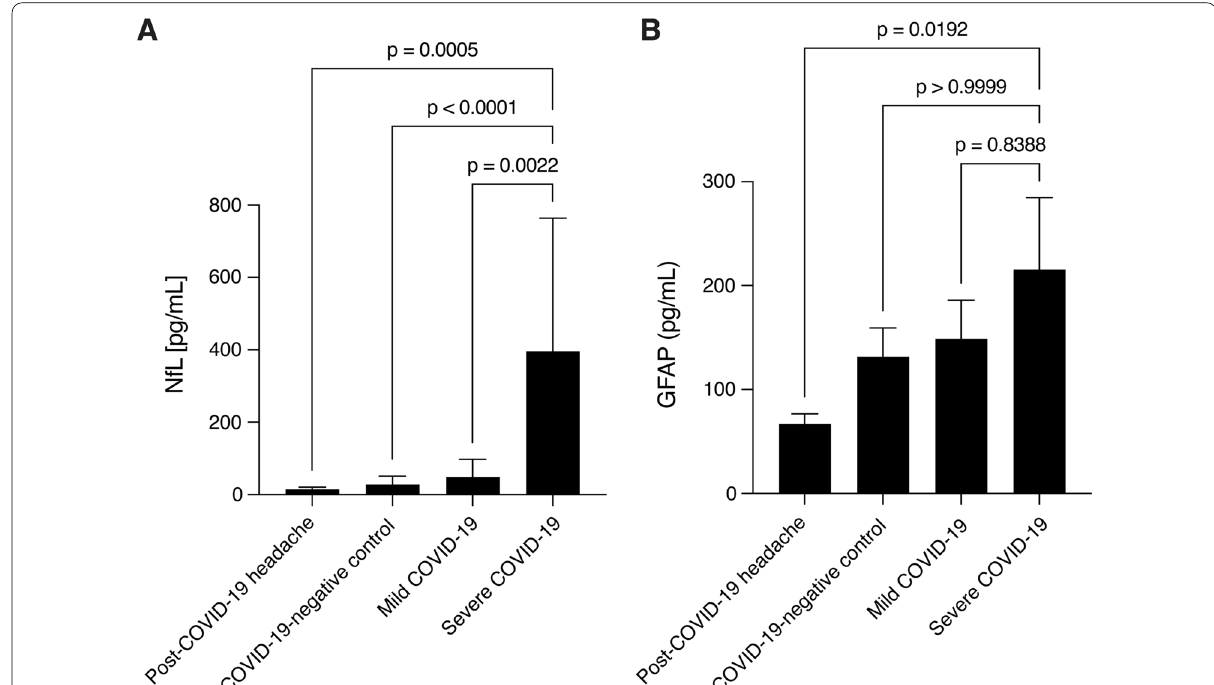
Fig. 1 NfL and GFAP levels. A NfL levels in severe COVID-19 (n 11) are significantly higher compared to persistent Post-COVID-19 headache = (n 6), mild COVID-19 (n 17) and COVID-19-negative controls (n 14; Kruskal–Wallis test followed by Dunn’s multiple comparisons test). B GFAP = = = levels in persistent Post-COVID-19 headache (n 6) were similar to compared to mild COVID-19 (n = significantly lower compared to severe COVID-19 (n 4; Kruskal–Wallis test followed by Dunn’s multiple comparisons =